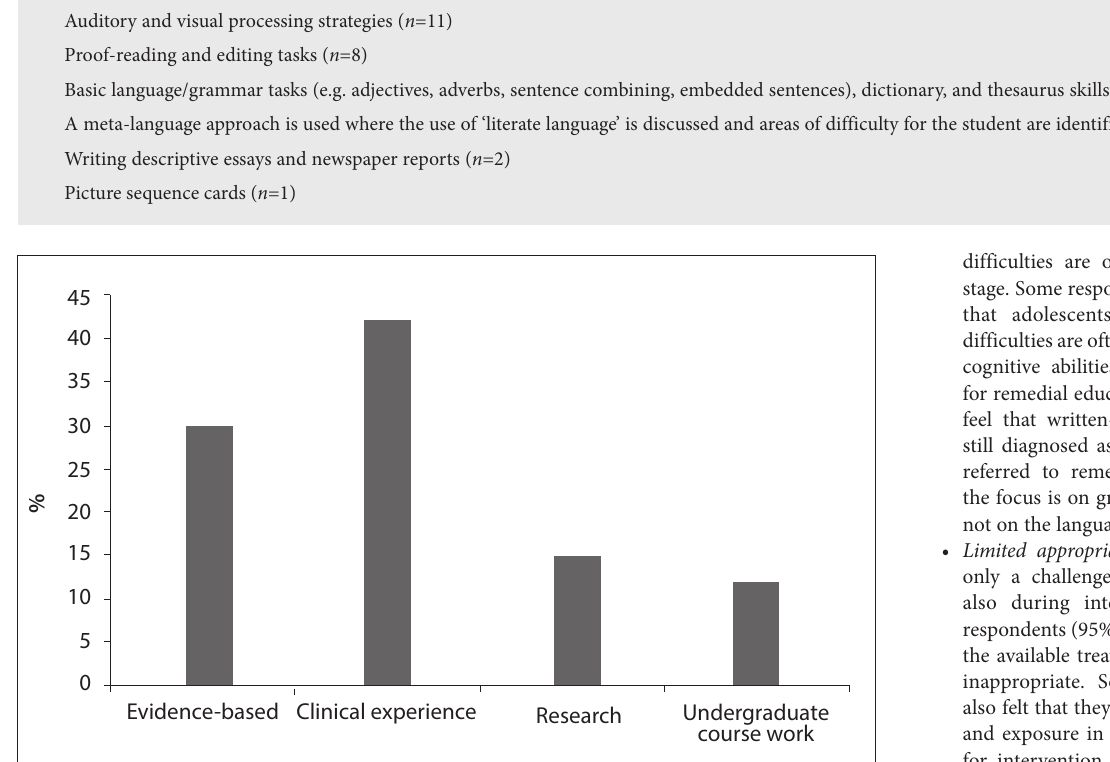
Fig. 1. Respondents’ ( n =22) intervention